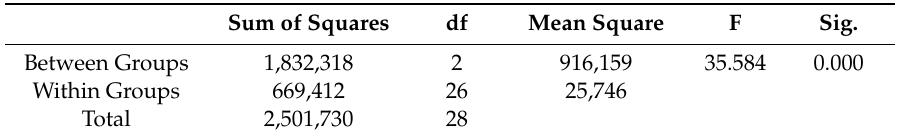
Figure 16. Mean plots. Table 11. One-way ANOVA (Y33).